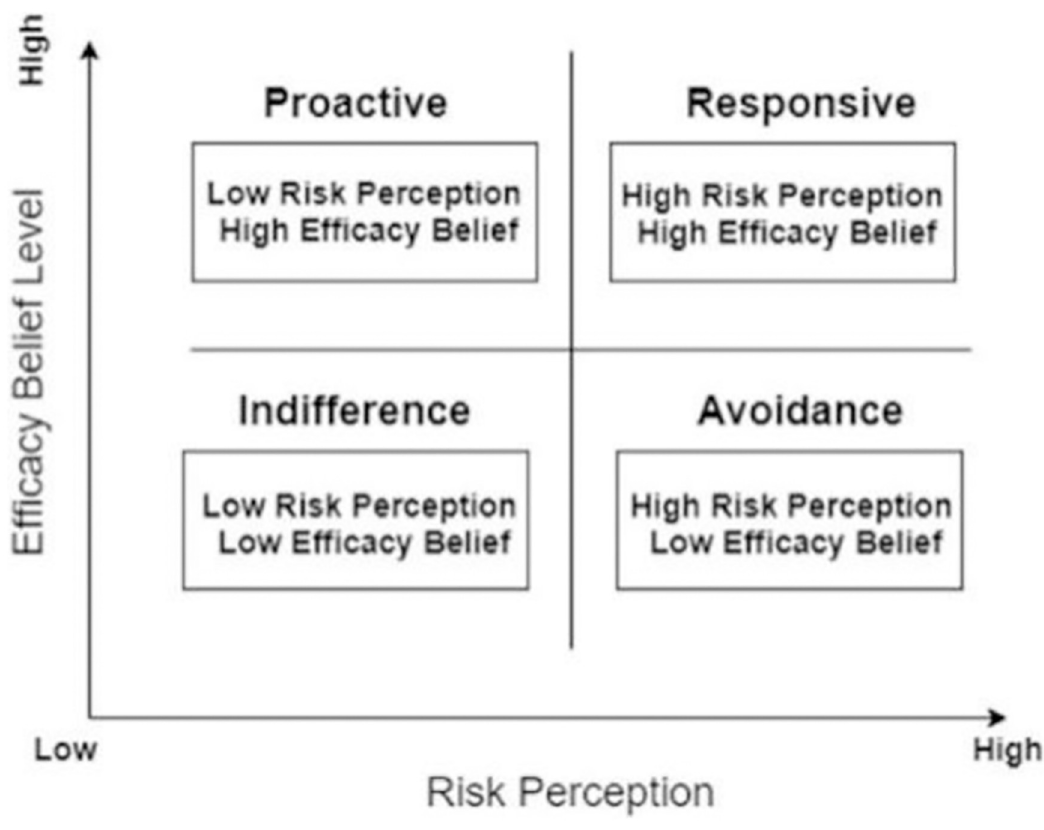
Fig 2. Risk perception attitude framework. Source: Chisty, Islam